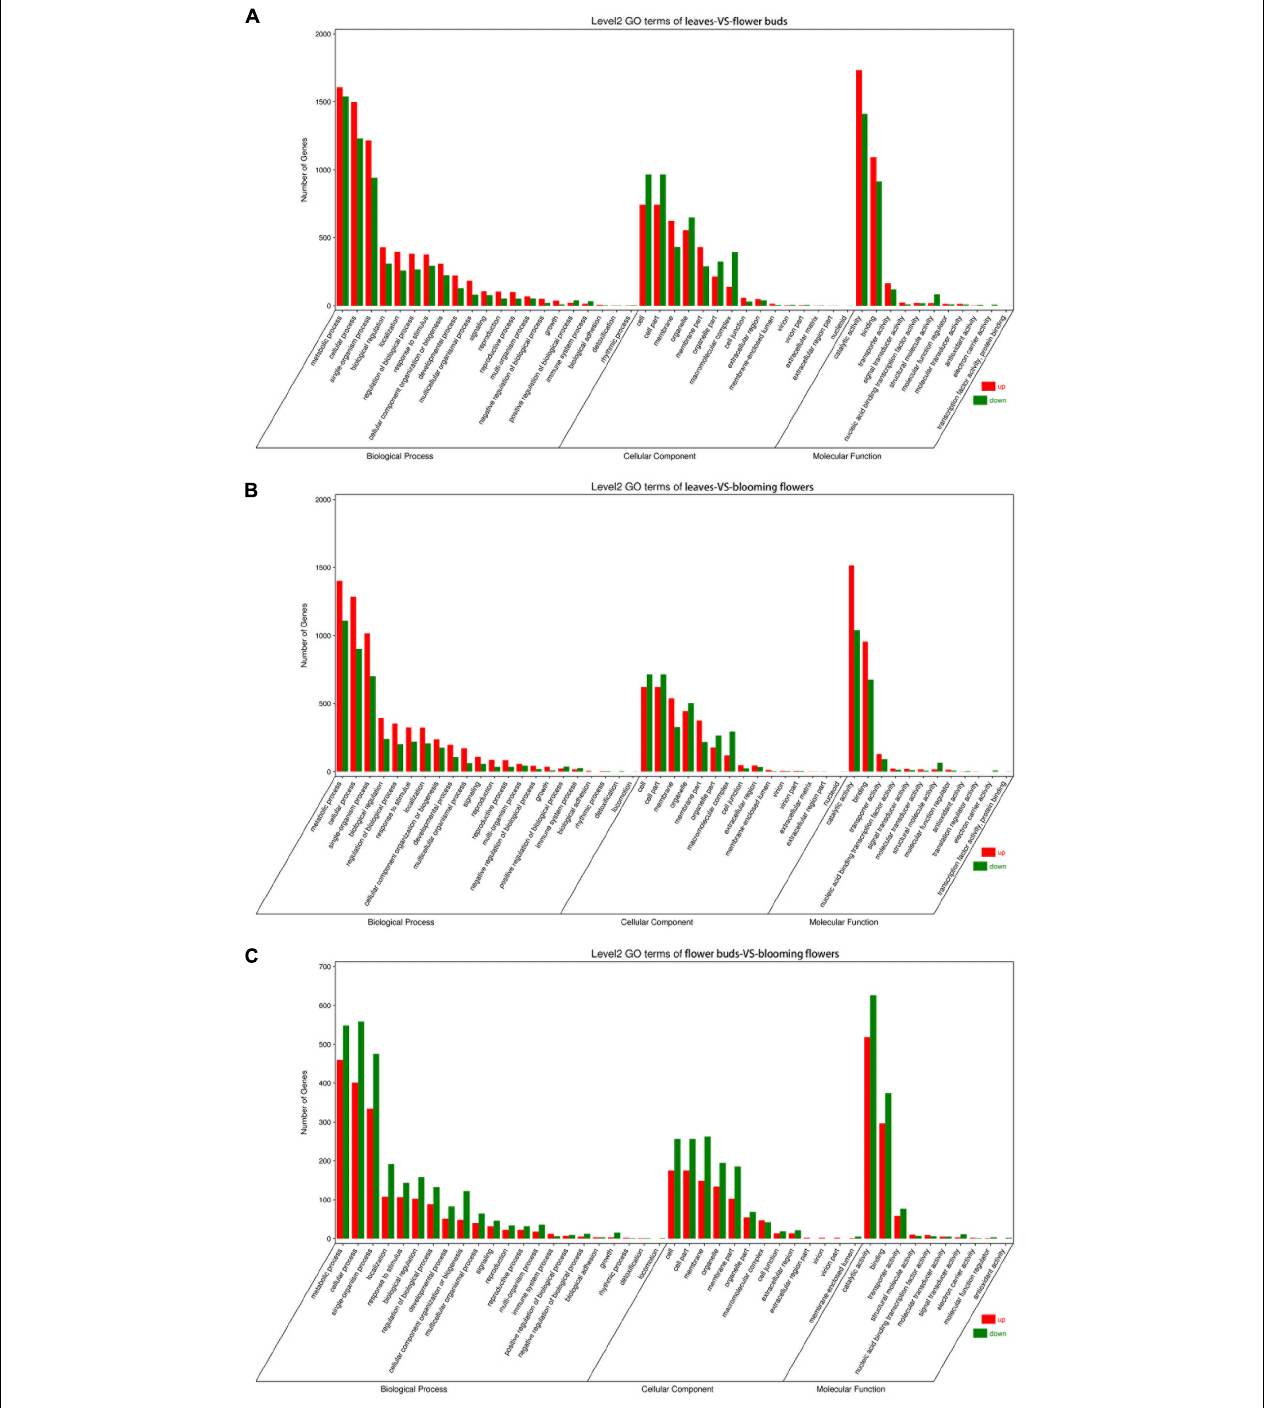
FIGURE 6 | GO term classification of differentially expressed genes among Chrysanthemum dichrum plant tissues. The GO classification of all genes was divided into three parts: Biological Process, Cellular Component and Molecular Function. (A) Shows the GO classification of the differentially expressed genes in the leaves and flower buds comparison group, and (B) shows the GO classification of the differentially expressed genes in the leaves and blooming flowers comparison group. (C) Shows the GO classification of differentially expressed genes between the flower buds and blooming flowers comparison group.